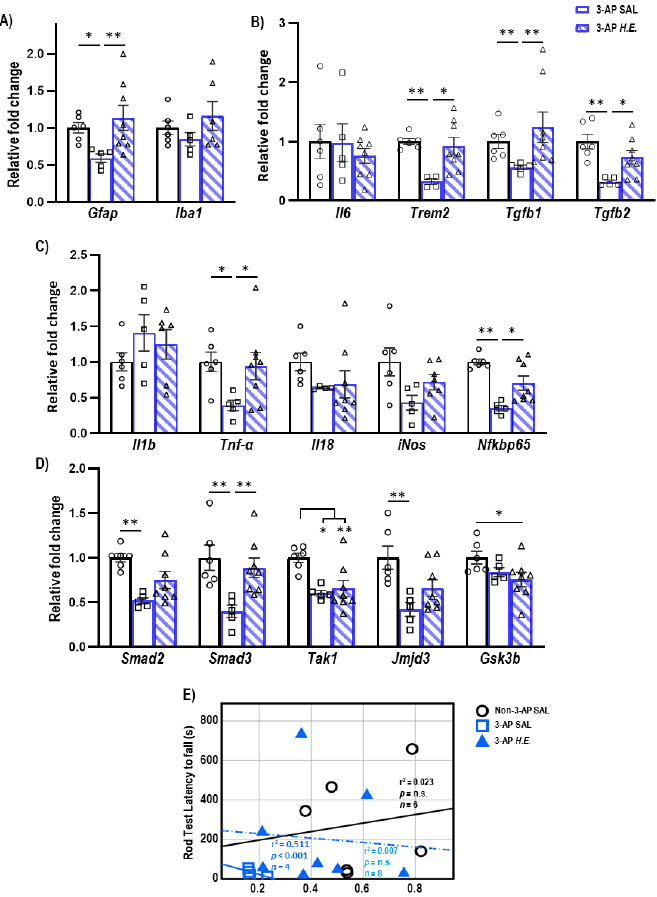
Figure 1. Effects of 3-AP and H.E . treatment on the relative expression of inflammatory genes in the cerebellum. ( A ) Relative expression of glial-related genes: Gfap and Iba1 . ( B ) Relative expression of anti-inflammatory genes: Il6 , Trem2 , Tgfb1, and Tgfb2 . ( C ) Relative expression of pro-inflammatory genes: Il1b , Tnf - α , Il18 , iNos , and Nfkbp65 . ( D ) Relative expression of TGF- β signaling-related genes: Smad2 , Smad3 , Tak1 , Jmjd3, and Gsk3b . ( E ) Correlational analysis between Tgfb2 genes and latency to fall in the rod test. Indicators: * p -values ≤ 0.05, ** p -values ≤ 0.01, Non-3-AP SAL group, 3-AP (cid:35) SAL group, 3-AP H.E. group.